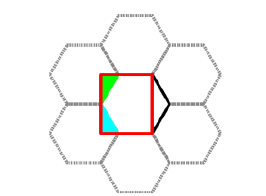
Figure 3. Auxiliary rectangle and above (green) and bellow (blue) areas